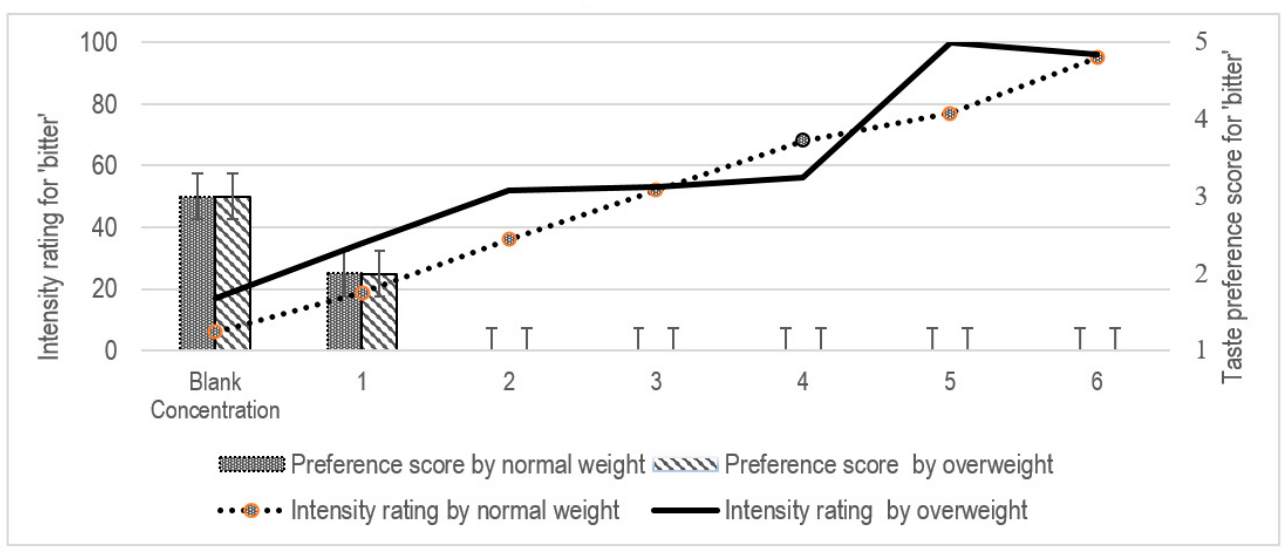
Figure 3. Intensity rating and taste preference for ‘bitter’ between the study groups. Table 3. Spearman’s rho correlation for taste sensitivity and taste